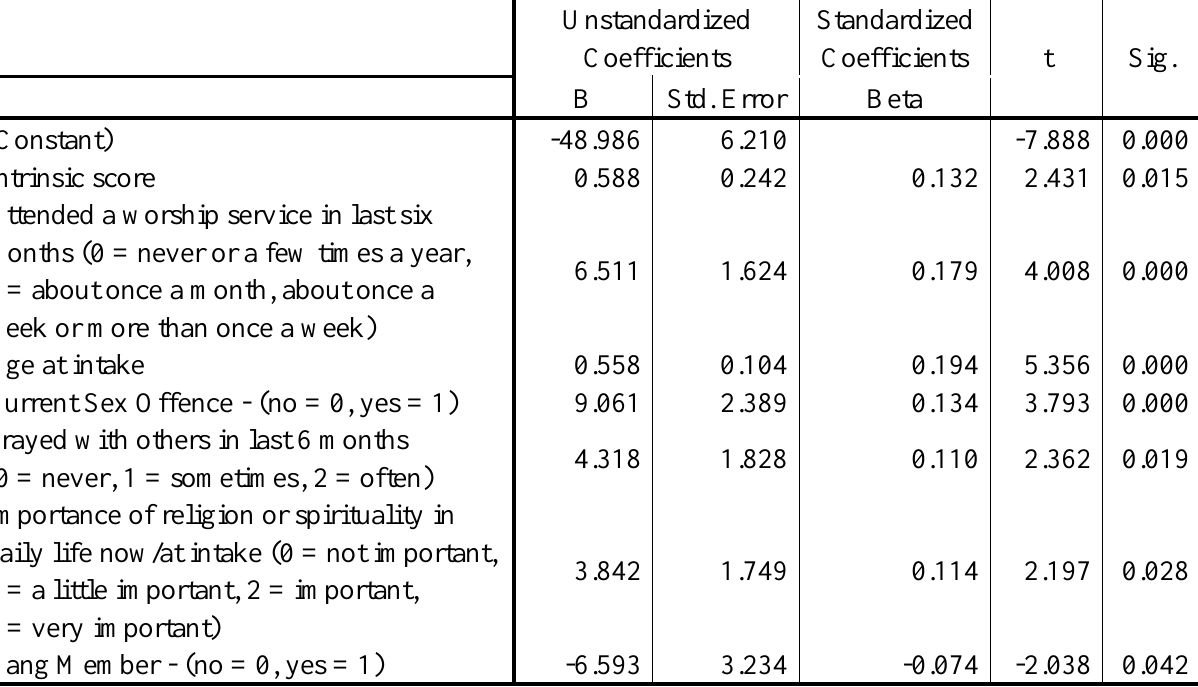
Table 4. Linear Regression Model Predicting Number of Attendances for Men Who Took an H/S/R Assessment at Intake.